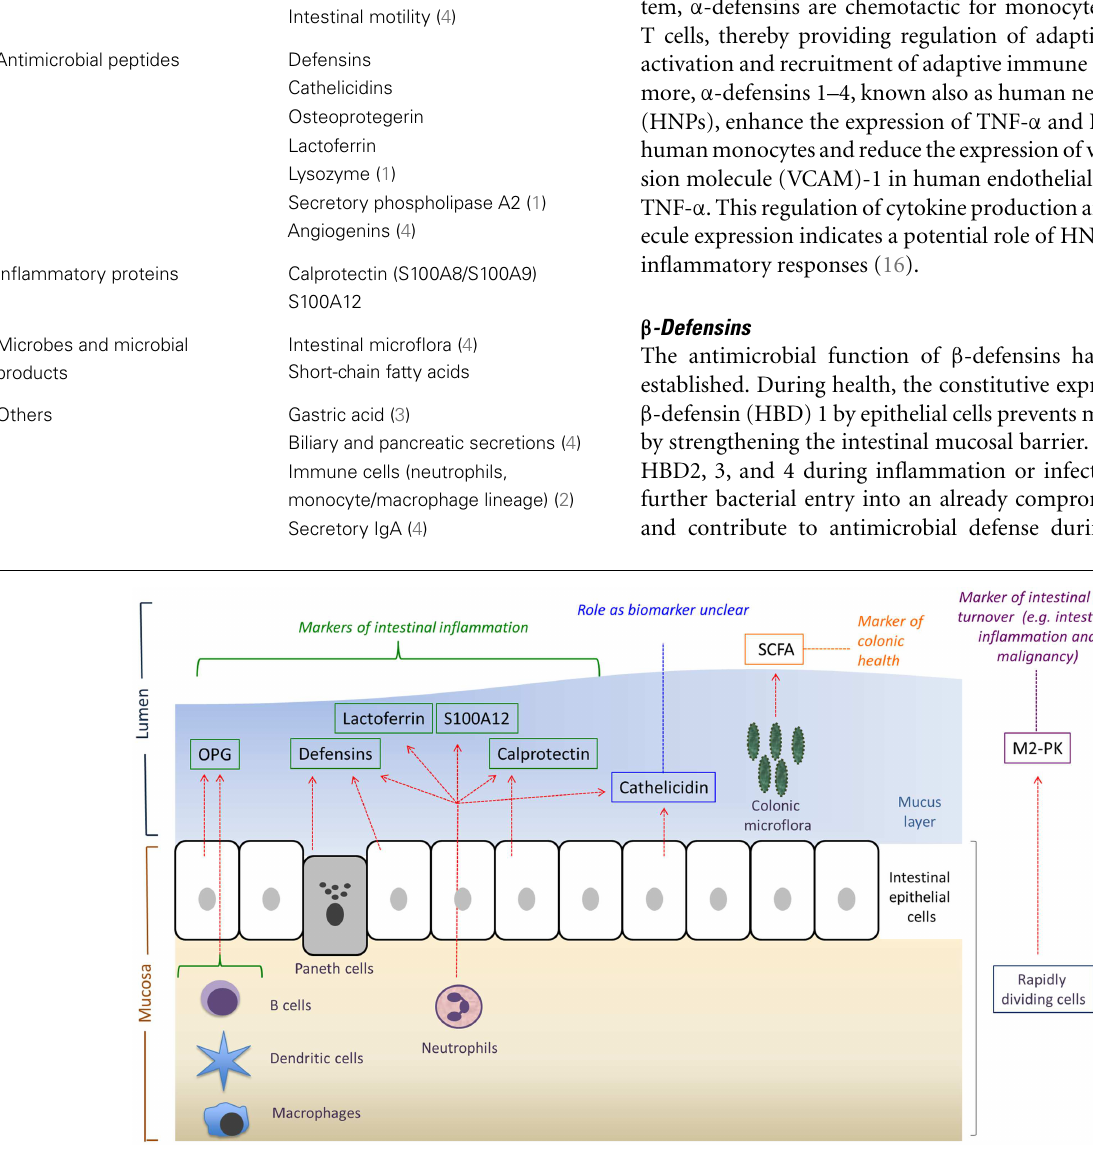
Frontiers in Pediatrics | Pediatric Gastroenterology and